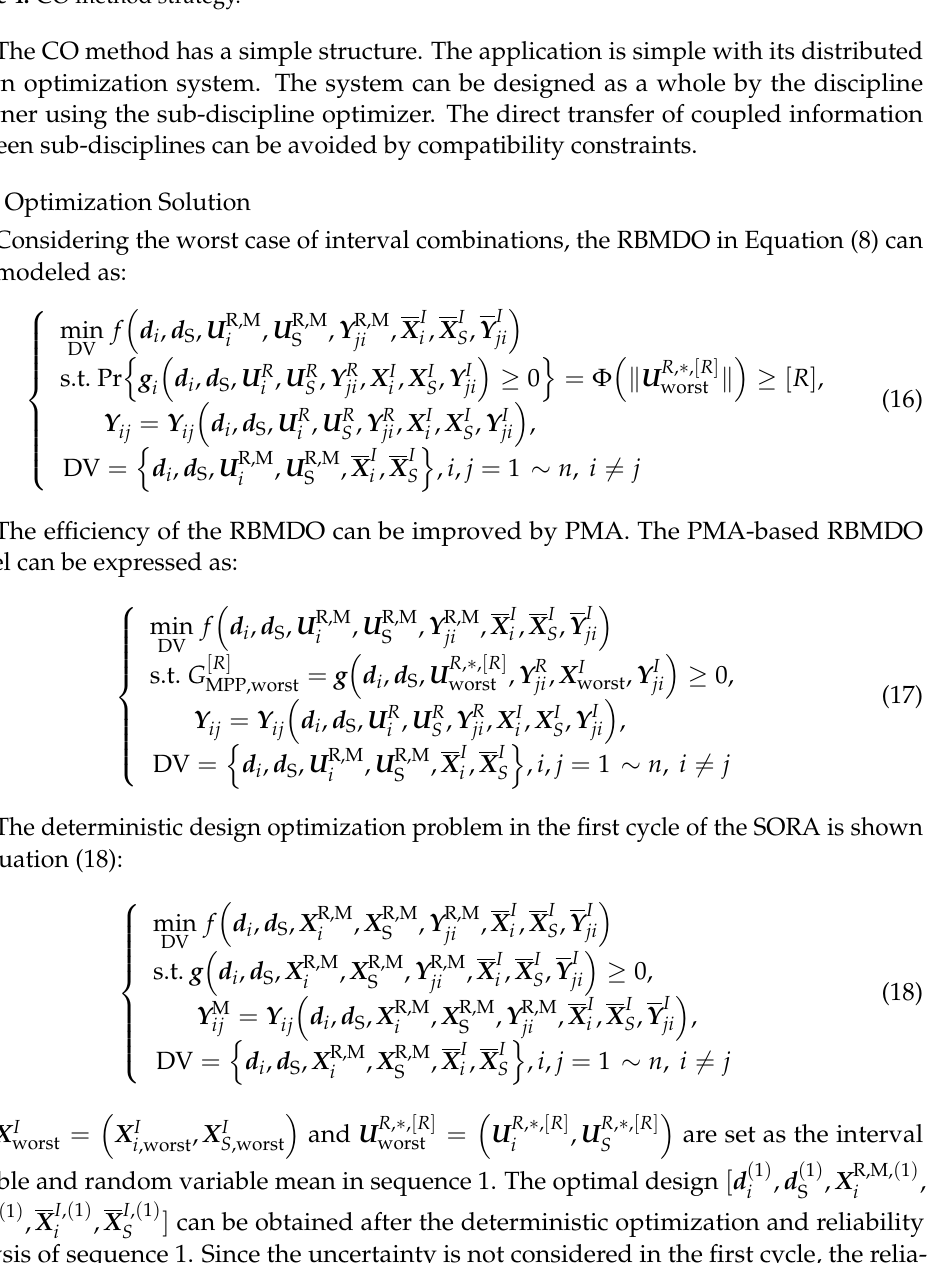
Figure 4. CO method strategy.